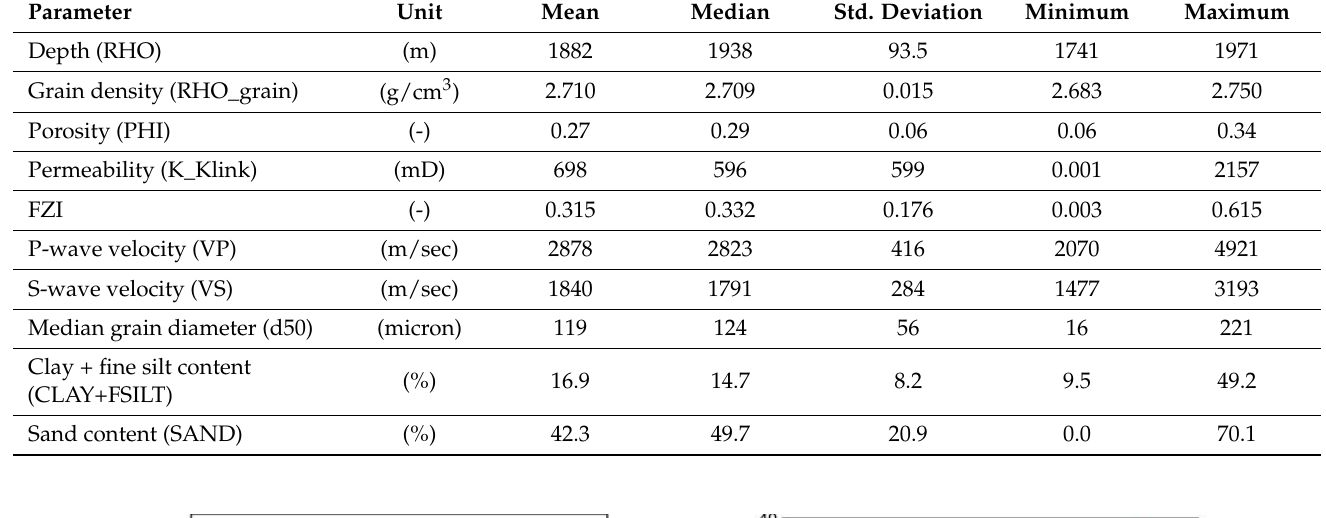
Table 3. Descriptive statistical values of 121 tested petrophysical and textural parameters.